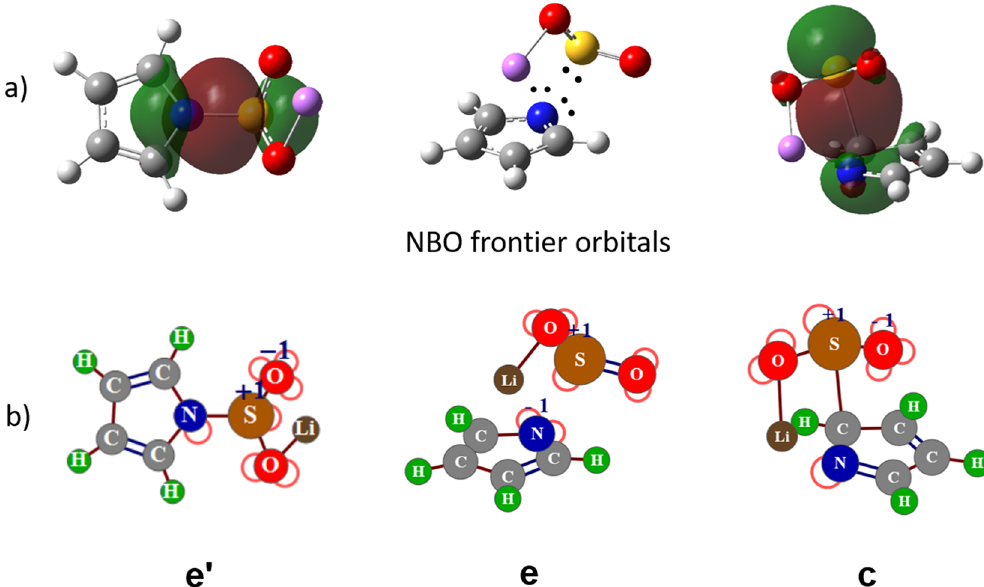
Figure 3. ( a ) NBO decomposition of the N/C-S bond of three stable configurations of pyrrolide 1-Li + -SO 2 , respectively. In e , its frontier NBO orbitals are represented by three electron long pairs on N (two pairs) and S (one pair). Dots represent electron lone pairs. ( b ) Leading Lewis resonance structures of the corresponding complexes. Red half circles represent electron lone pairs.